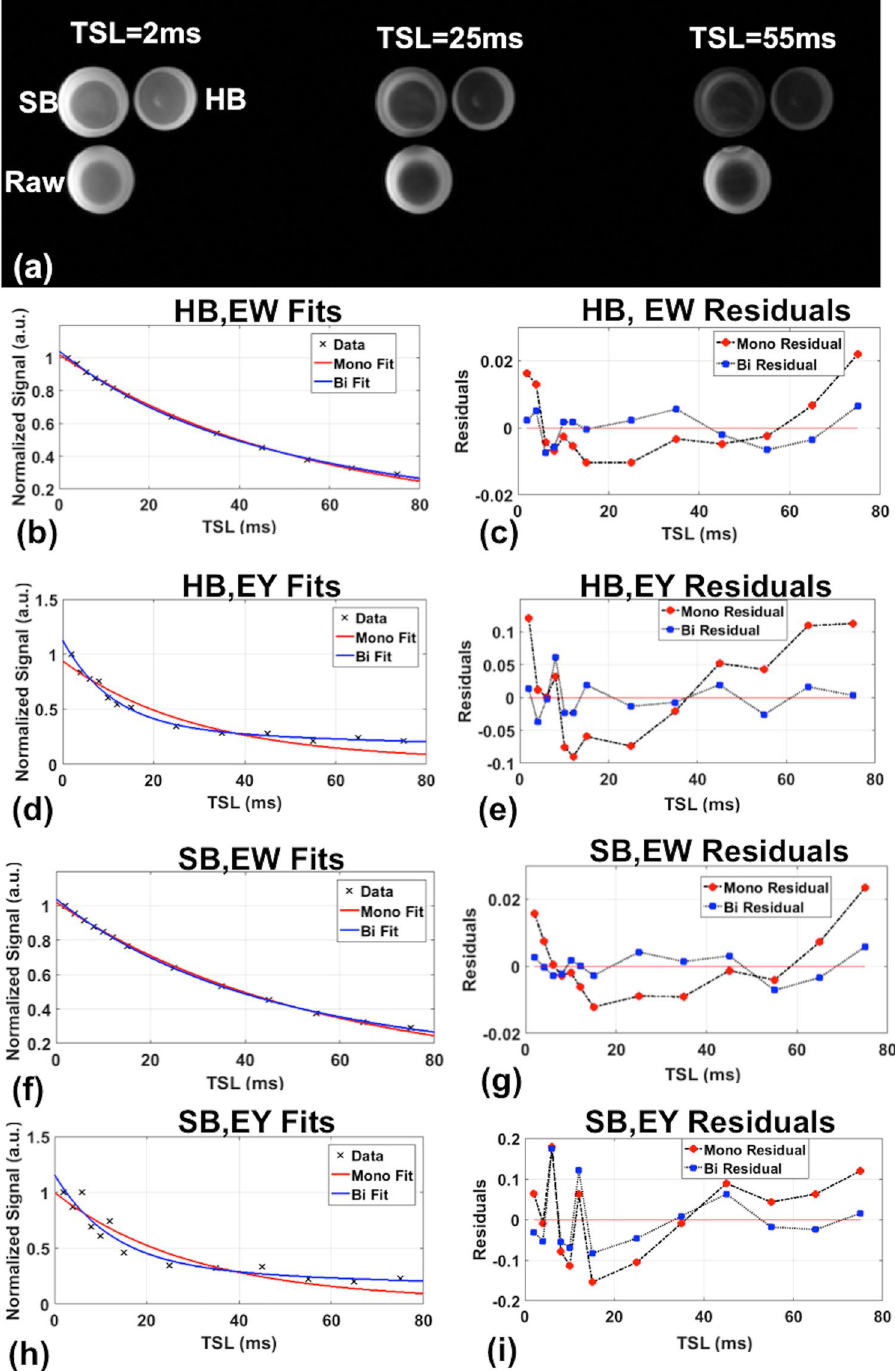
Figure 1. Sample egg images of HB, SB and raw egg at three representative TSL values ( a ). Signal decays with mono- and bi-exponential fits in the hard-boiled egg white ( b ), yolk ( d ), their residuals ( c , e ) and soft-boiled egg white ( f ), yolk ( h ) and their residuals ( g , i